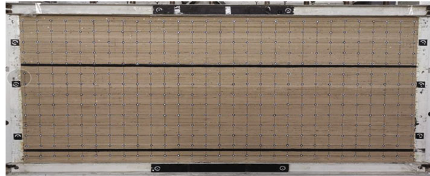
Figure 8: Schematic diagram of the similar material